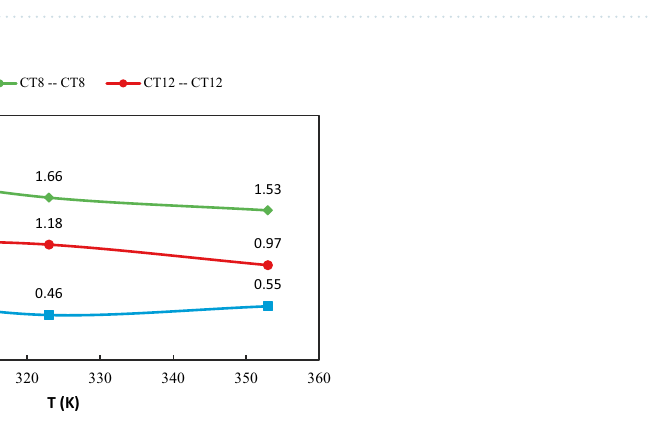
Figure 3. The regions of the LUA molecule in the binary mixture: CT4 (blue ellipse), CT8 (green ellipse), and CT12 (red ellipse).